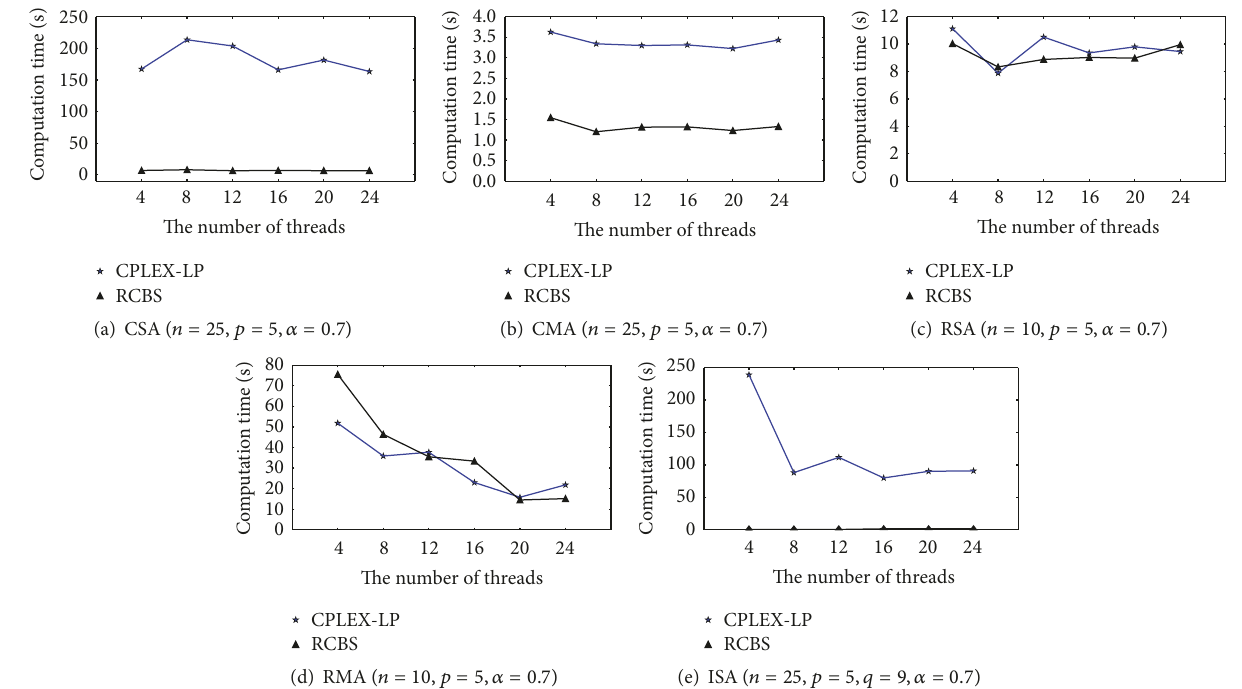
Figure 11: Computation time of LP and RCBS with different number of threads for the CAB dataset: for the RMA problem, the computation time of two solution techniques can be reduced significantly with an increasing number of threads. For the ISA problem, the computation time of CPLEX-LP can be reduced by adding the threads when the number of threads is less than a fixed number (here, the fixed number is